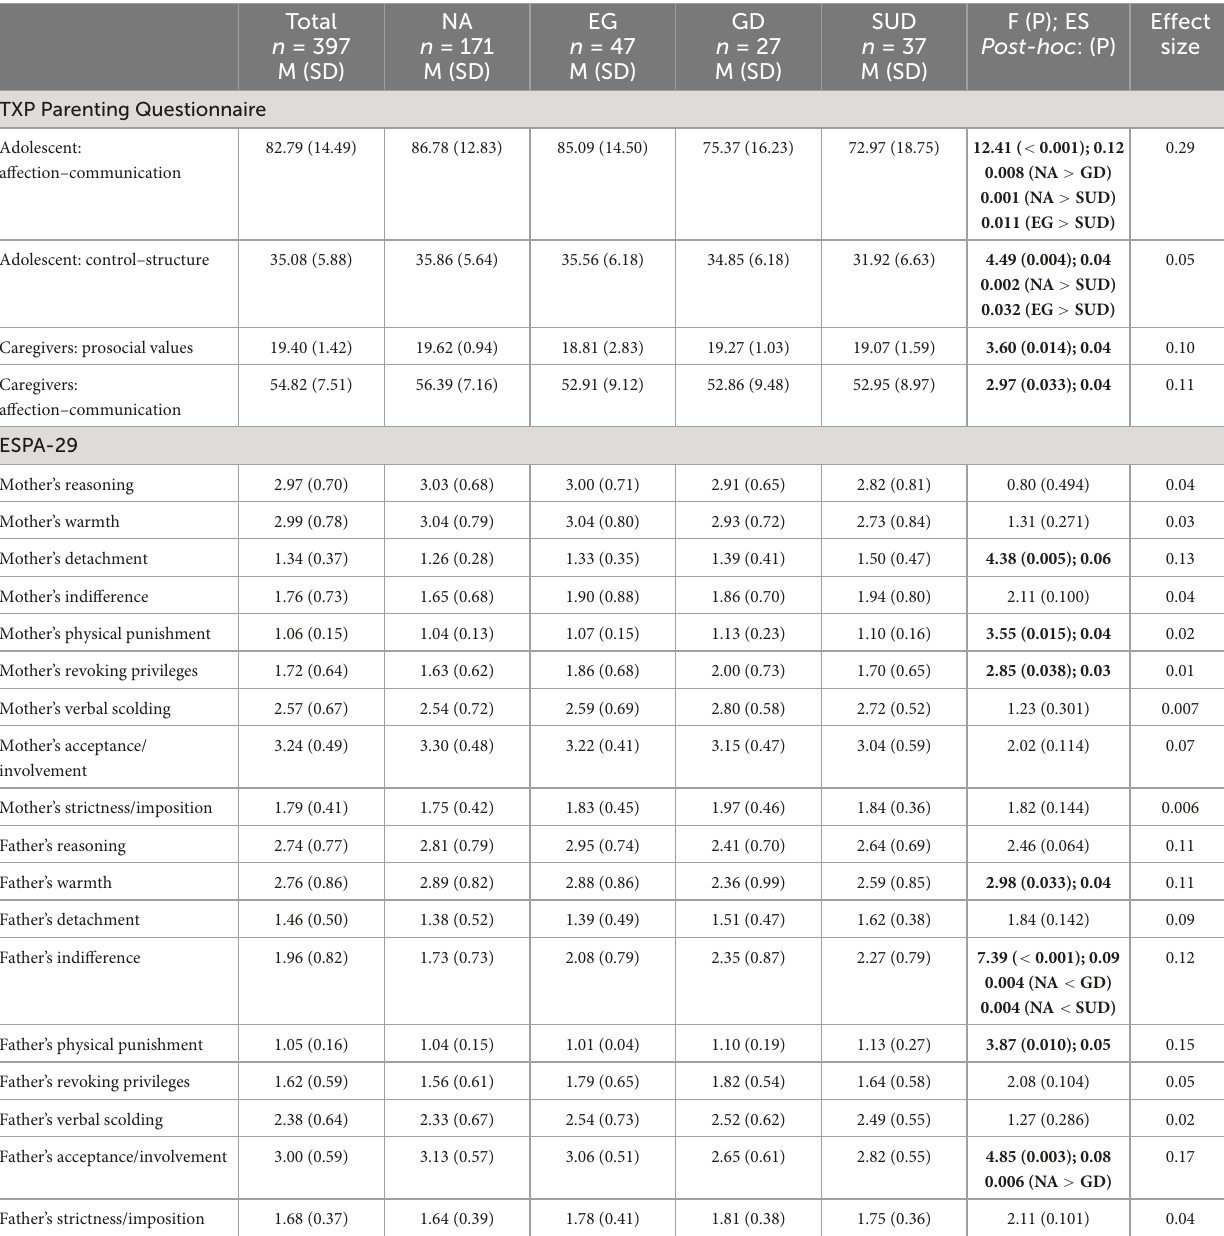
TABLE 2 Descriptive statistics of parenting of the overall sample and by the no addiction, Excessive Gaming, Gaming Disorder, and Substance Use Disorder